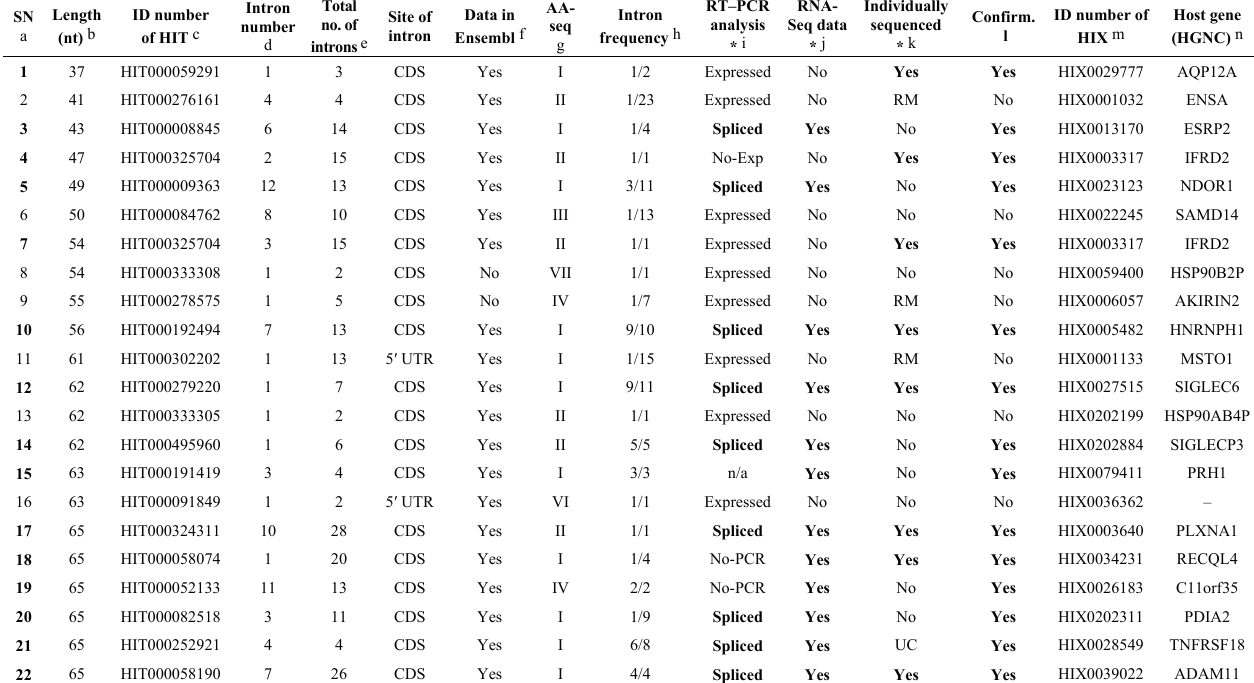
a Serial number (SN). The 15 ultra-short introns that were confirmed are highlighted in bold font (see “Confirmation”); b Intron length within the ultra-short range ( ≤ 65 nt); c H-InvDB transcript (HIT) identifier; d Intron number (position) in the host gene (in the HITs); e Total number of introns (in the HITs); f Whether or not the intron is also found in the Ensembl transcript database (“Yes” or “No”); g Levels of sequence similarity of the encoded amino-acids (AA) sequence to known proteins or protein domains; h Intron frequency in the aligned HITs represented by the ratio of the number of HITs spliced at the ultra-short introns to the number of all aligned HITs across the ultra-short intron region; i The RT–PCR detection of the endogenous splicing or transcription. “ Spliced ”: splicing of endogenous ultra-short intron was observed. “Expressed”: splicing was not observed but transcription was observed; “No-Exp”: expression was not detected by RT–PCR but genomic PCR worked properly. “No-PCR”: PCR did not work, even with genomic DNA. “n/a”: RT–PCR could not performed because of the difficulty in designing a primer for the repetitive region; j Whether splicing of the ultra-short introns could be checked in mRNA-Seq data (“ Yes ”) or not (“No”); k Whether the transcripts were cloned and sequenced individually by researchers in the INSDC databases (“ Yes ”) or whether they just automatically sequenced in high-throughput studies (“No”). “RM” indicates that the original accession data were removed by the contributors, and “UC” indicates that the description was unclear. In the case of SN12, the original accession data were removed (CR600025 in INSDC), but the individually sequenced data were proposed by another source (D86358 in INSDC); l Confirmation of the ultra-short introns if at least one of three experimental studies (labeled with *) is positive (“ Yes ”), otherwise no evidence (“No”); m H-Invitational cluster (locus, HIX) identifier; n Approved gene symbols by HUGO Gene Nomenclature Committee